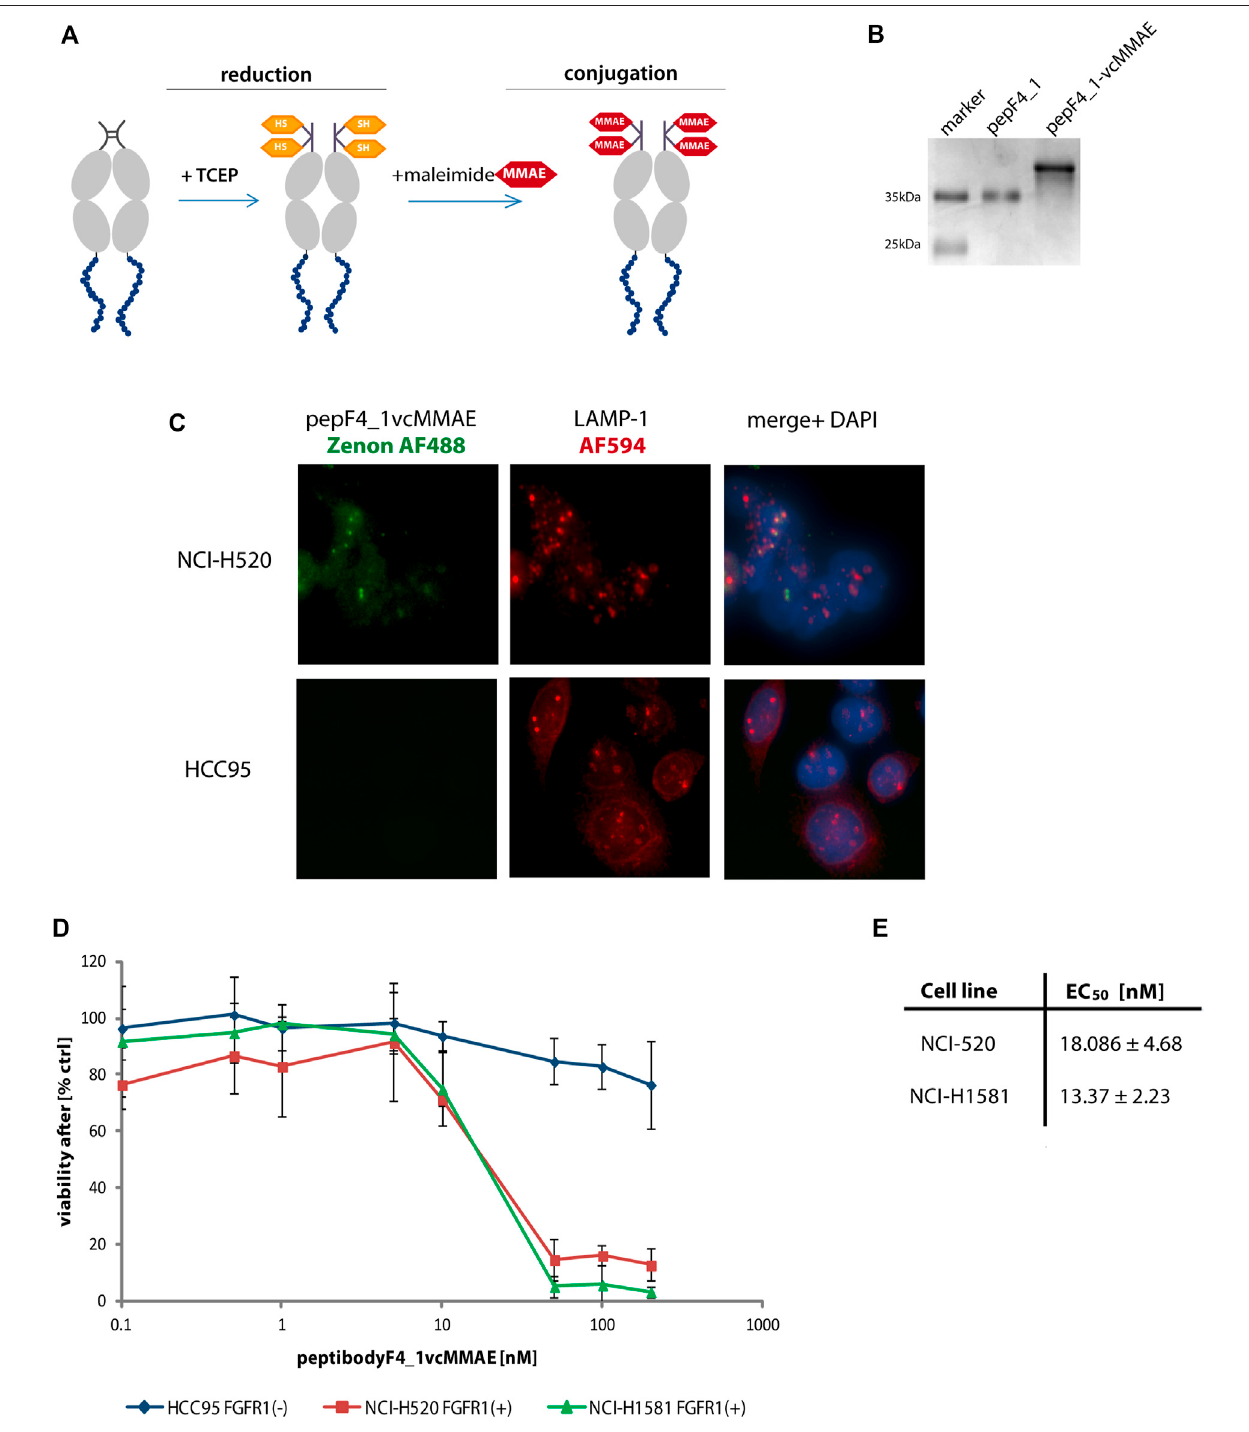
FIGURE 5 | PeptibodyF4_1 was ef fi ciently conjugated with monomethylauristatin E. (A) Scheme representing the stages of conjugation with cytotoxic payload via maleimide reaction. (B) Complete substitution of a peptibodyF4_1 by a monomethylauristatin E was con fi rmed by SDS-PAGE electrophoresis and CBB staining. (C) NCI-H520(FGFR1-positivecells)andHCC95(controlcells)wereincubatedwithpeptibodyF4_1vcMMAEconjugate.Lysosomeswerelabeledwithanti-LAMP1antibody (red), peptibodyF4_1vcMMAE conjugate was visualized with Zenon-AF488 reagent, and nuclei ware stained with NucBlue reagent. (D) Cytotoxicity of peptibodyF4_1 towards cancer lung cell lines. Comparison of cytotoxic effect of conjugate on FGFR1-positive cell lines (NCI-H520, NCI-H1581) and FGFR1-negative celllines(HCC95).Allexperimentswerenormalizedtothevaluesfornon-treatedcellsrecognizedas100%.Theerrorbarsrepresent ± SDfor n (cid:2) 3experiments. (E) EC 50 values for peptibodyF4_1vcMMAE for NCI-H520 and NCI-H1581 cell line, respectively. EC 50 values were obtained based on the Hill equation using Origin 7 software (Northampton,